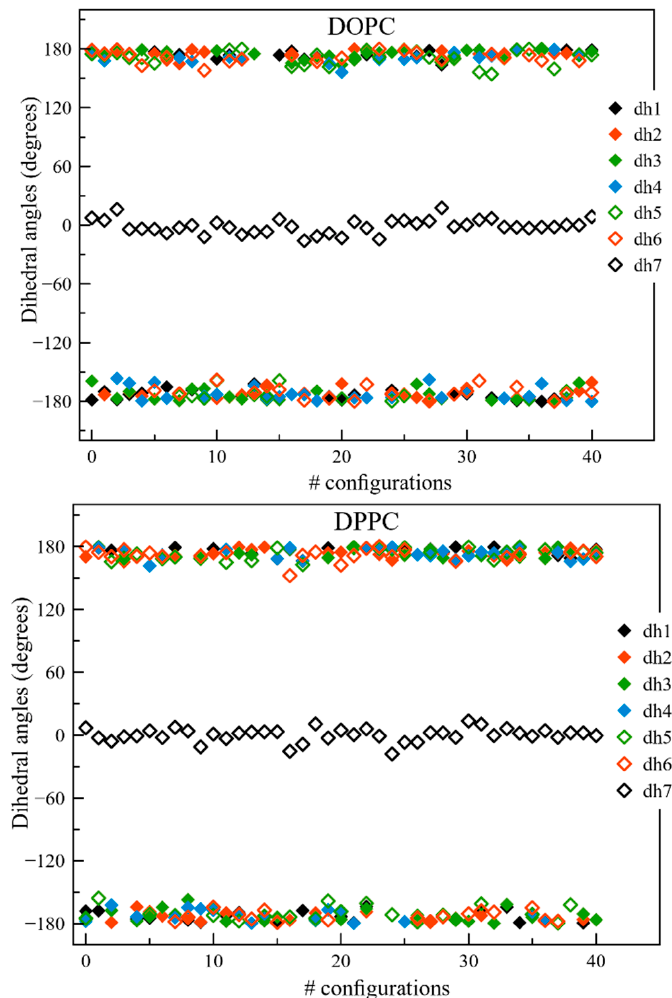
Figure A5. Values of the 7 dihedral angles of DPH observed in all 40 snapshots selected over the trajectories for DOPC (Ld) and DPPC (So). dh7 is defined with respect to the opposite side of the phenyl ring compared to dh1.